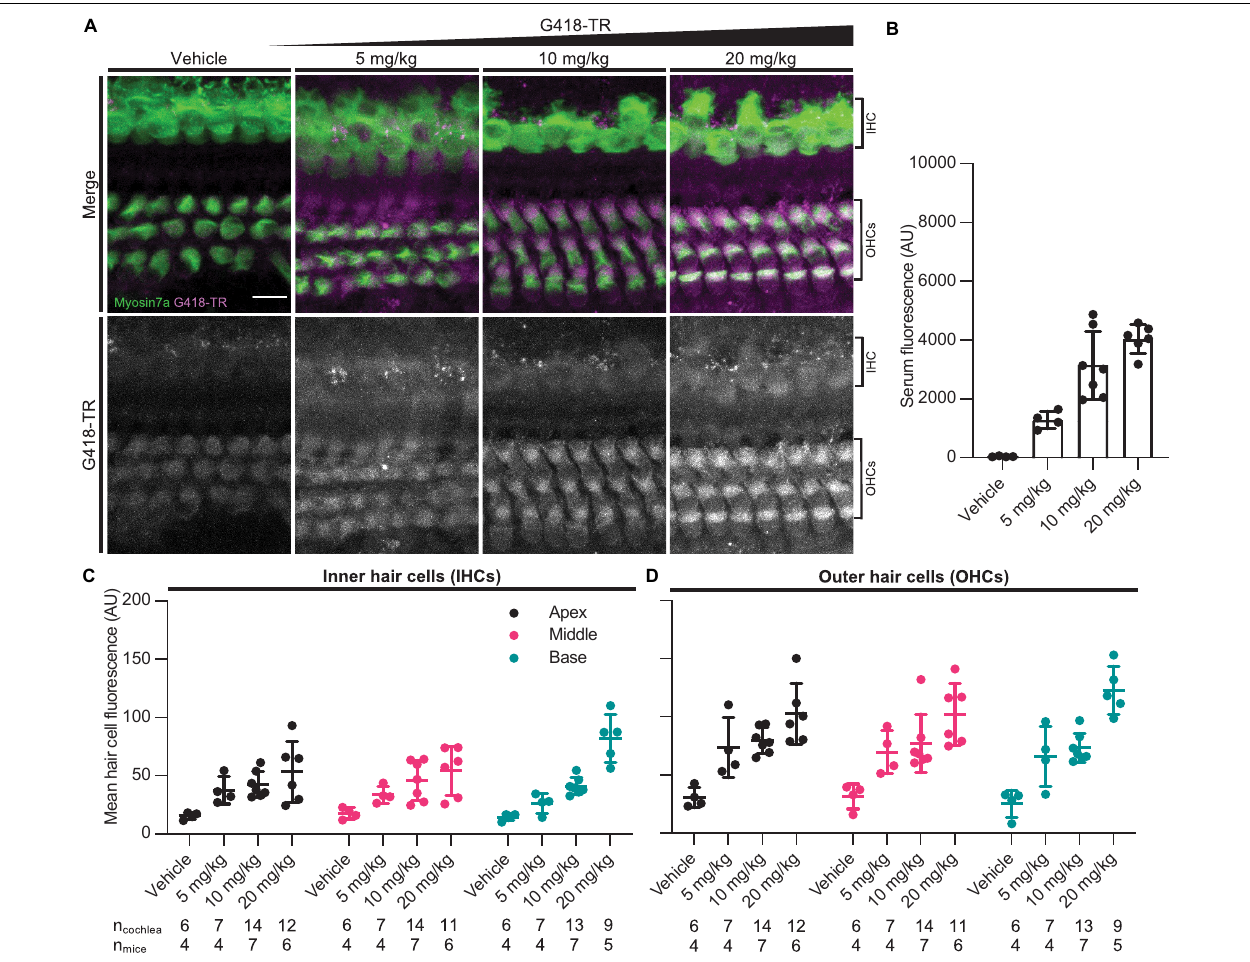
FIGURE 2 | G418-TR is taken up by mature mammalian hair cells following systemic administration. (A) At 6 h after systemic injection with G418-TR, juvenile mice (P25-30) were sacrificed, cochlear sensory epithelia was dissected and fixed, and tissue was immunolabeled for myosin VIIa. Representative maximum projection images captured from the middle turn of the cochlea demonstrate dose-dependent uptake of G418-TR in inner and outer hair cells. Scale bar = 10 µ m. (B) 6 h after systemic administration of G418-TR, blood was collected from juvenile mice, serum was extracted, and fluorescence was quantified with a fluorescence plate reader. Increasing doses of G418-TR results in a dose-dependent increase in serum fluorescence [One-way ANOVA; F ( 3 , 17 ) = 28.28, P < 0.0001]. (C) Mean G418-TR fluorescence intensity of IHCs by tonotopic region 6 h after systemic treatment. IHCs demonstrate low uptake at most doses of G418-TR with no significant tonotopic variation. (D) Mean G418-TR fluorescence intensity of OHCs by tonotopic region 6 h after systemic treatment. OHCs demonstrate dose-dependent uptake but not tonotopic variation in G418-TR uptake. n cochlea and n mice represent the number of cochlea and mice examined, respectively. When two cochlea from the same animal were analyzed, the animal mean was calculated and used for all statistics and graphs. Error bars are standard deviations. AU, arbitrary unit.